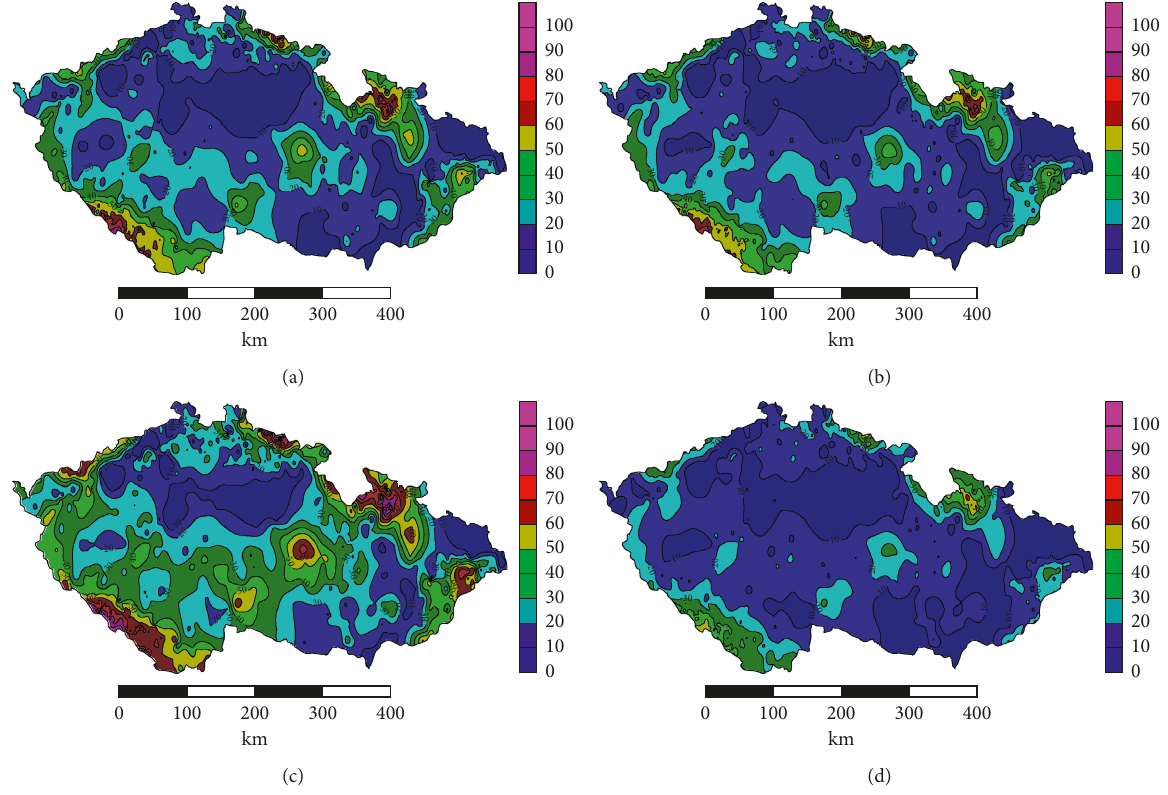
Figure 7: IFTC outputs for (a) AAC, (b) ceramic brick, (c) hollow clay brick, and (d) sandstone